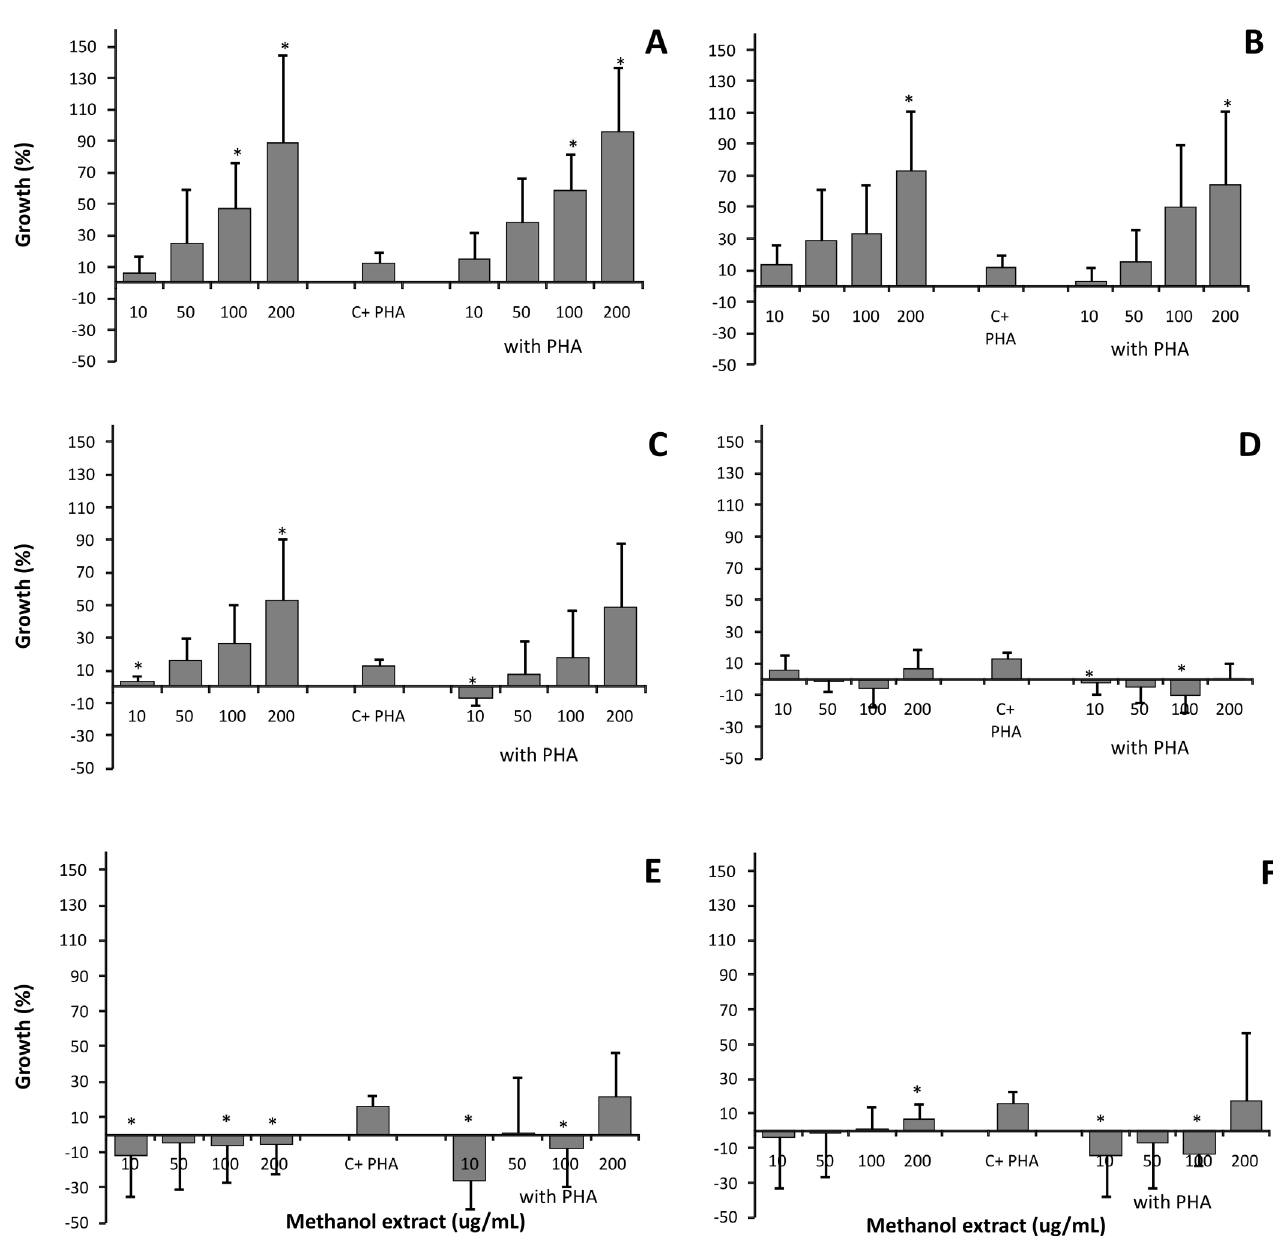
FIGURE 1 - Percentage growth of murine spleen cells treated with methanol extracts from different medicinal plants, in the presence or absence of mitogenic stimulation with phytohemagglutinin (PHA), for 72 hours at 37 °C and 5% CO B: Ipomea pes-caprae ; C: Matayba elaeagnoides ; D: Maytenus robusta ; E: Rubus imperialis , F: Vernonia scorpioides ; C+PHA: positive control phytohemagglutinin (PHA), * p < 0.05 compared to C+PHA. Results are presented as the mean and standard deviation of four experiments performed in